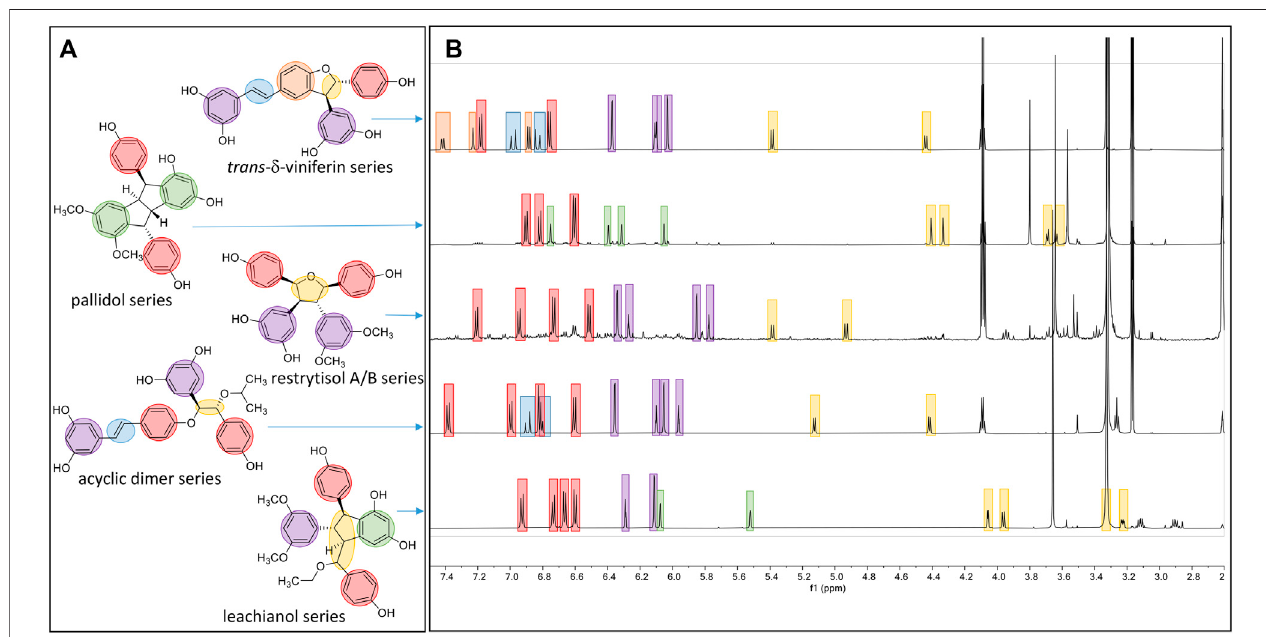
FIGURE 5 | Overview of the typical 1 H-NMR shifts of the different scaffolds generated. (A) Five compounds representing the fi ve main scaffolds obtained by the biotransformations reactions. (B) The typical 1 H-NMR spectra of each scaffold is highlighted in blue for the trans double-bound; orange for the 1,3,4-trisubstituted aromaticcycle;red forapara-disubstituted system; purpleforthe1,3,5-trisubstitutedaromaticcycle;greenforthetwometa coupled proton;and yellow forthemethine protons.